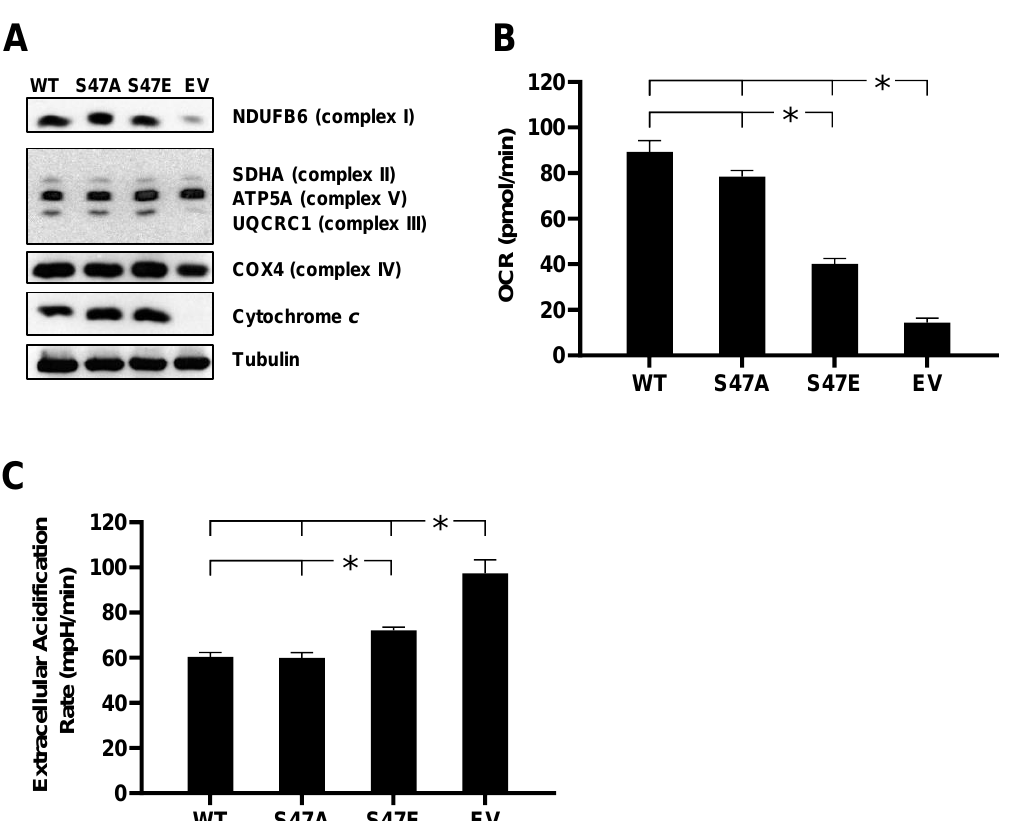
Figure 1. ( A ) Cytochrome c (Cyt c ) double-knockout cells stably transfected with empty vector (EV) and wild type (WT), S47A, S47E Cyt c expression constructs were immunoprobed for Cyt c , together with loading control tubulin, and OxPhos complex subunits NDUFB6 (complex I), SDHA (complex II), UQCRC1 (complex III), COX4 (complex IV), and ATP5A (complex V). ( B ) Oxygen consumption rate (OCR) of intact cells stably expressing EV and WT, S47A, S47E Cyt c measured in Seahorse media supplemented with 10 mM galactose using the Seahorse bioanalyzer ( n = 9–13). ( C ) Extracellular acidification rate (ECAR) of intact cells as a measure of the rate of glycolysis measured in Seahorse media supplemented with 10 mM glucose and 10 mM sodium pyruvate ( n = 4–6). Data are represented as means ± SEM, * p < 0.05.